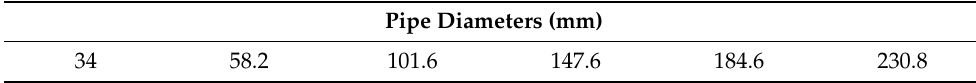
Table 3. Available pipe diameters for the re-design of the